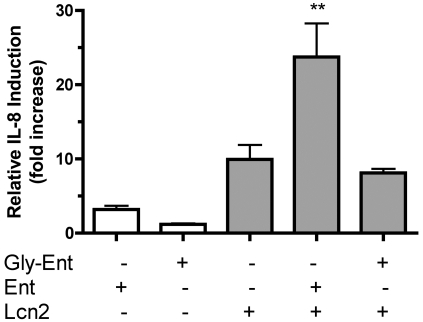
Lipocalin 2 does not stimulate IL-8 release from A549 respiratory cells in response to glycosylated enterobactin.IL-8 release from cultured A549 respiratory cells was measured by ELISA after overnight stimulation with 50 µM Ent or Gly-Ent (Salmochelin S4) and/or 25 µM recombinant Lcn2 (shaded bars). Mean±SEM of fold-increase above vehicle control from at least three independent experiments is shown. ** p<0.01 comparing Ent-Lcn2 to all other stimuli as determined by one-way ANOVA with Tukey's multiple comparison test.